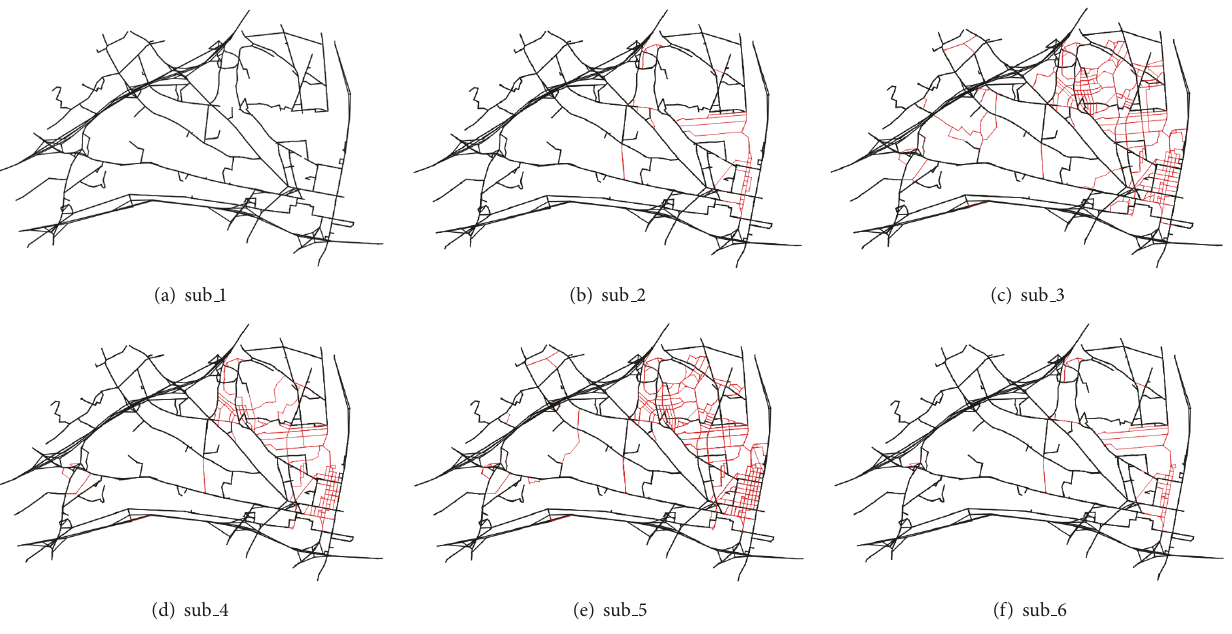
Figure 11: Abstracted map combinations. Table 1: Statistical information of the